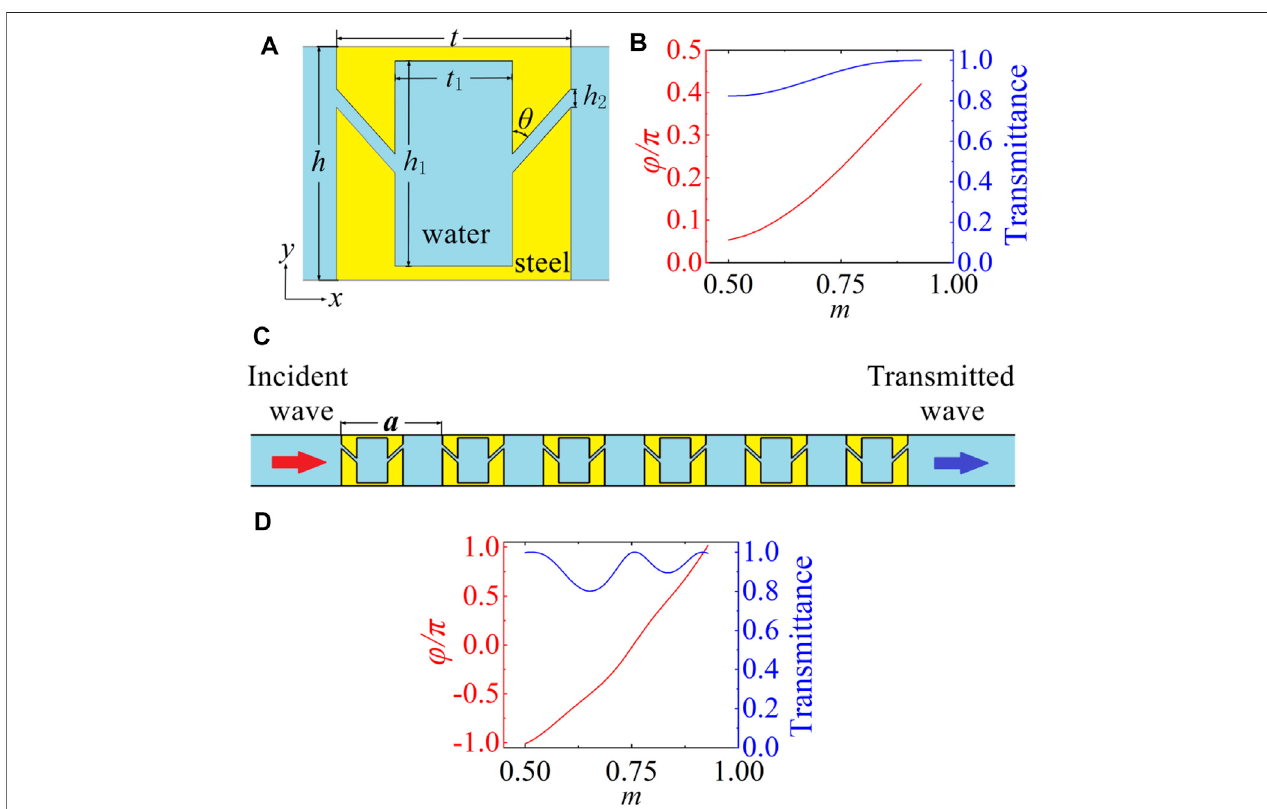
FIGURE 1 | Acoustic metasurface for the collimated and directional ultrasound emission. (A) Schematic of an individual unit. (B) Phase delay and transmittance of an individual element, as functions of the parameter m . (C) Schematic of a metasurface unit consisting of six identical cascaded elements, with the periodicity of the element being a (cid:1) 2 . 3mm. (D) Phase delay and transmittance of the unit as functions of the parameter m .